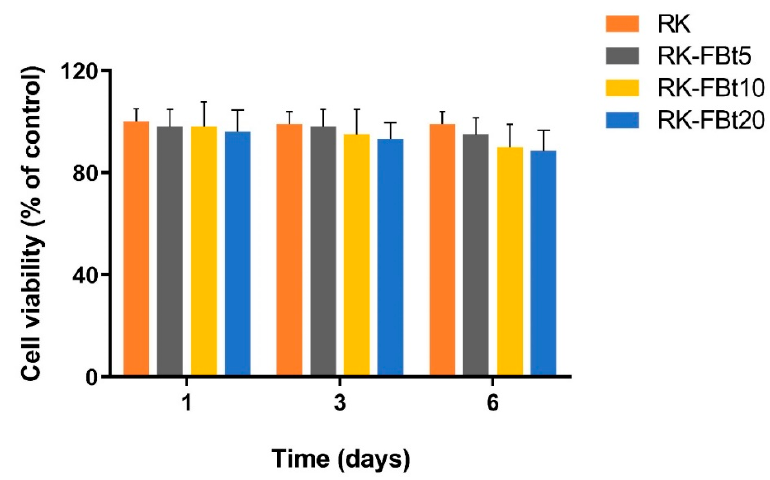
Figure 10. STRO-1+ cell viability assessed by CCK-8 assay on RK, RK-FBt5, RK-FBt10, and RK-FBt20 resins after 1, 3, and 6 days. The bars represent means ± SD ( n = 3).